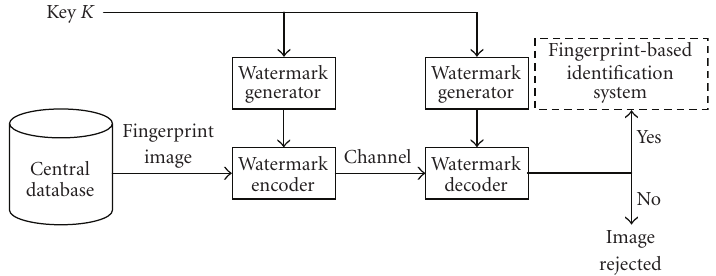
Figure 1: Block diagram of a watermarking application for fingerprint